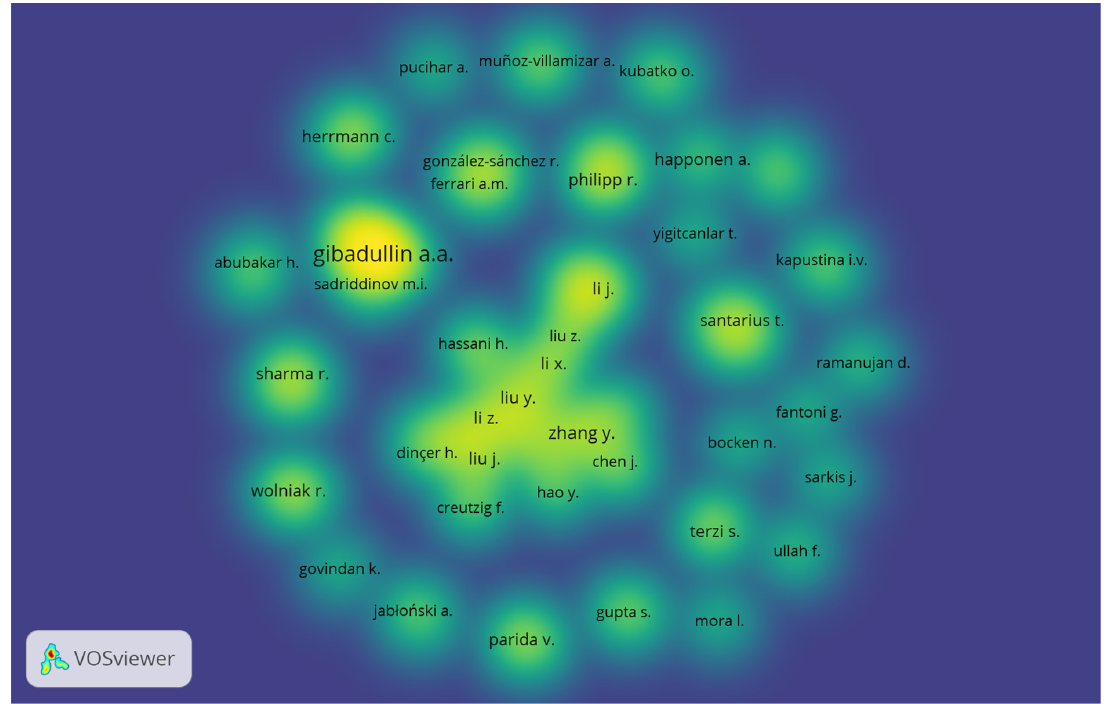
Figure 5. Graphical representation of the authors and the links between them, resulted from the interrogation of the Scopus database. Source: processing done by the authors with VOSViewer, based on the data interrogated in the Scopus database .